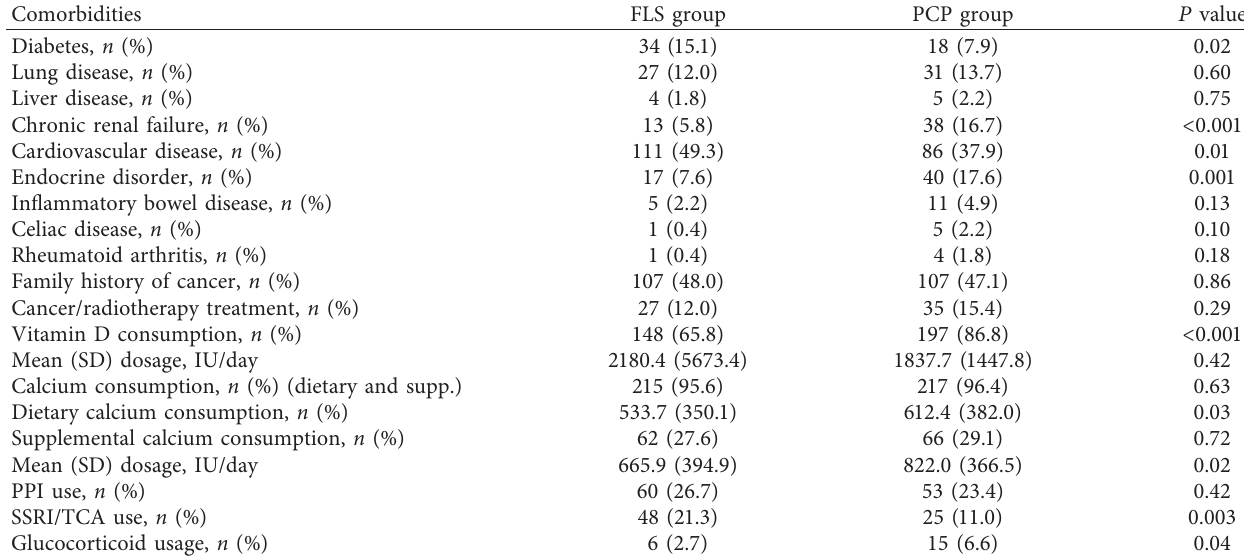
Table 2: Comorbidities, risk factors, and